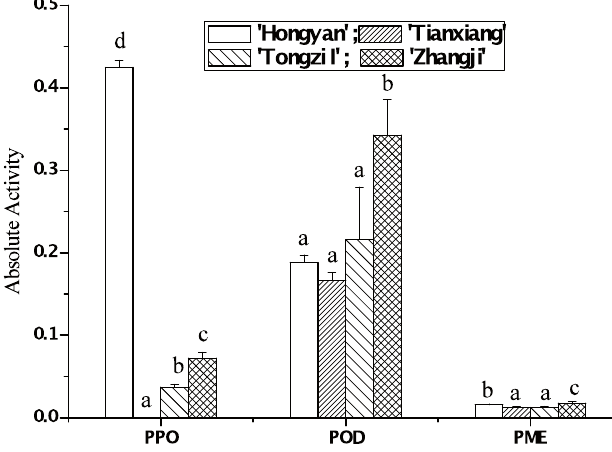
Fig. 3: The activity of PPO, POD and PME in selected four cultivars of